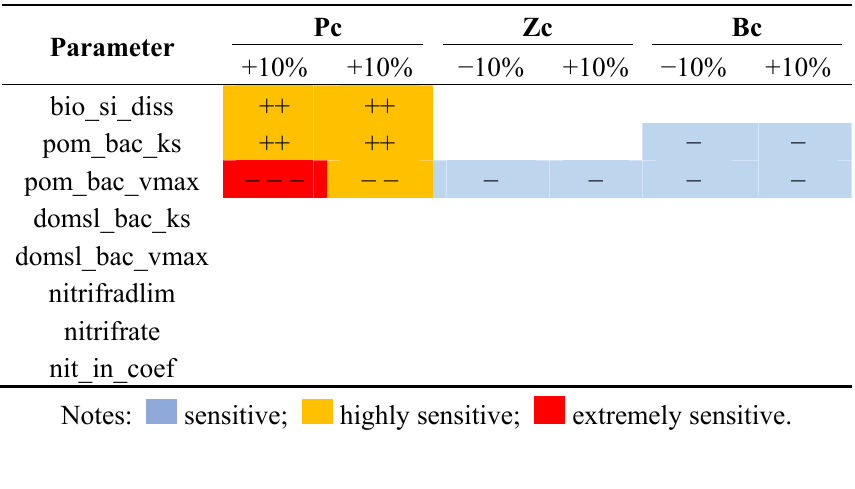
Table 8. Representation of the processing and interpretation of the SA result, Step 3: for a straightforward interpretation, the sensitivity value is converted to a qualitative descriptor, using signs (+ and − ) and a color scale to indicate positive or negative perturbation, and the degree of sensitivity of a variable to a given